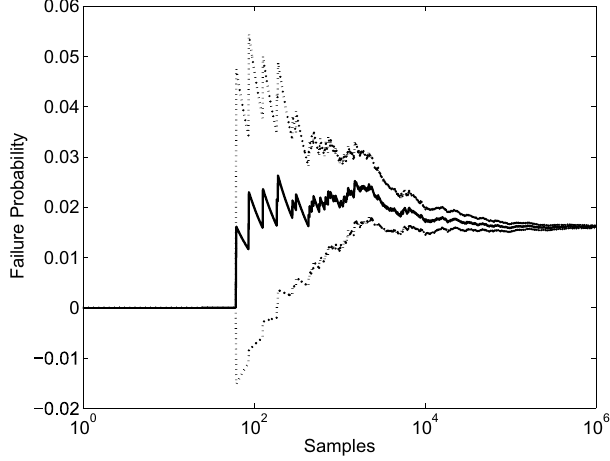
Fig. 10. Convergence of Monte Carlo